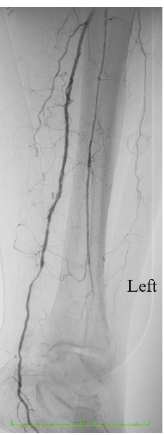
Figure 4: Postoperative angiography demonstrating flow to the left foot through the interposition long saphenous vein